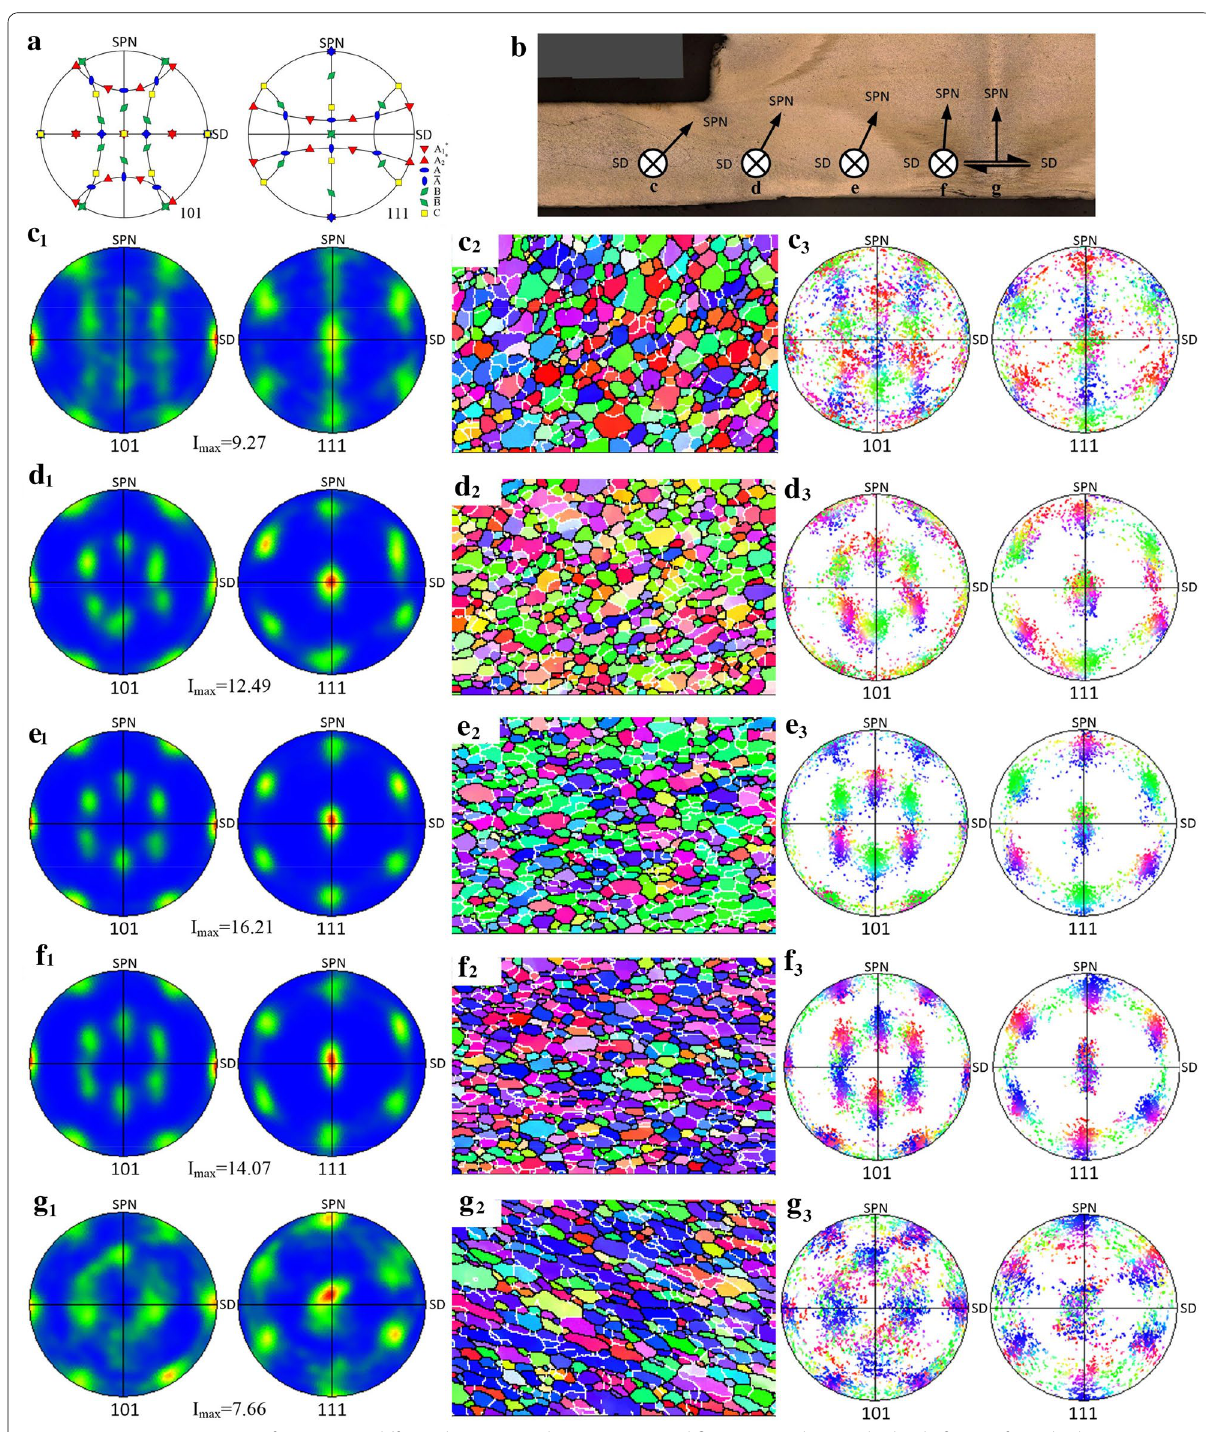
Figure 10 Grain orientation information at different locations in the vortex material flow zone: a the standard pole figure of simple shear texture [32]; b the shear direction (SD) and shear plane normal (SPN) at the different measured locations; c 1 - g 1 the pole figures corresponding to the locations c ‒ g in b ; c 2 ‒ g 2 the corresponding IPF maps under the SD and SPN coordinate; c 3 ‒ g 3 the color scattered figures corresponding to the IPF